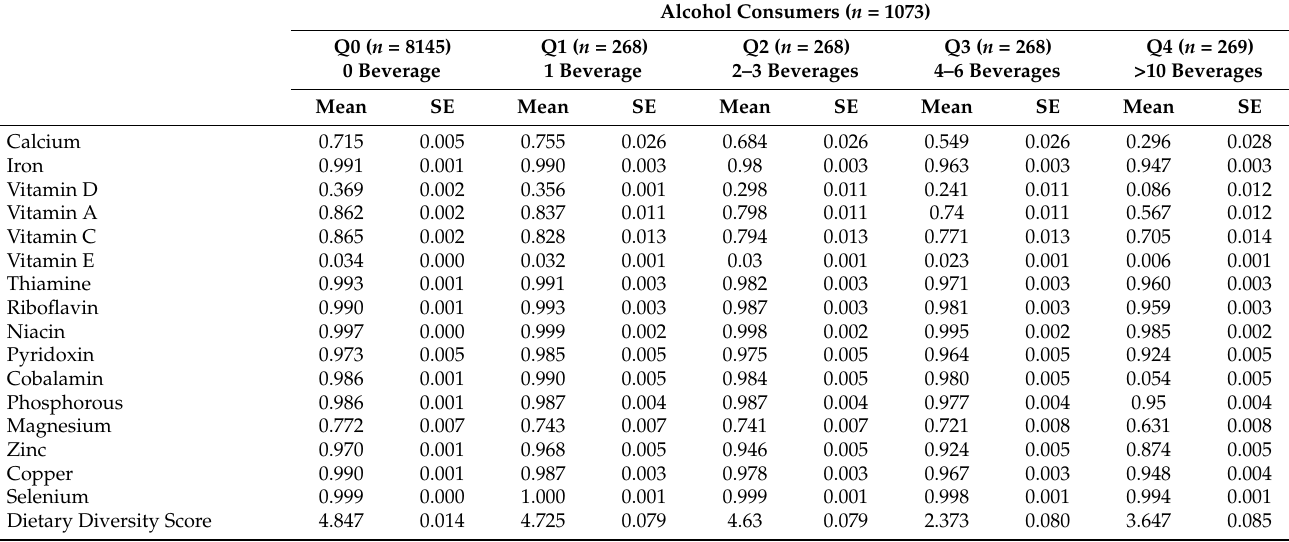
Table 8. Nutrients Adequacy Ratio and Dietary Diversity Score according to alcohol consumption